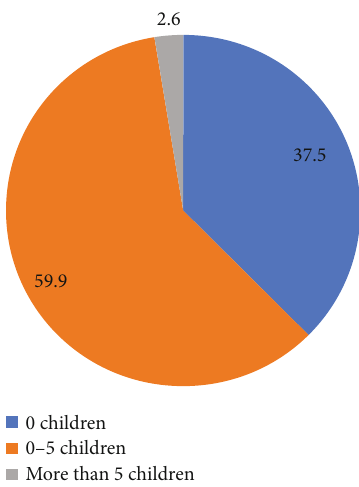
Figure 3: Percentage of mothers with live